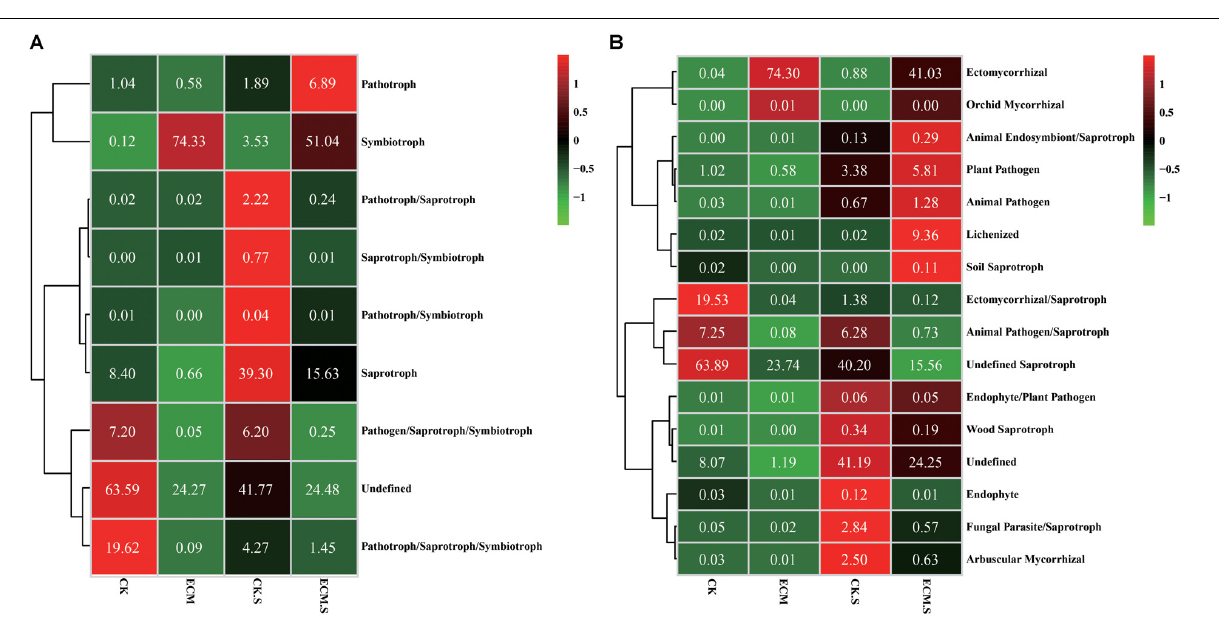
FIGURE 7 | Heat-map analysis of the fungal trophic mode (A) and functional group (guild) (B) in Q. aliena roots and the surrounding soil, inferred by FUNGuild. ECM, ectomycorrhizae; ECM.S, ectomycorrhizosphere soil; CK, roots of Q. aliena without T. indicum partner; CK.S, rhizosphere soil of Q. aliena without T. indicum partner. The values displayed in each color block indicate the relative abundance (%) of the corresponding fungal trophic mode or the functional